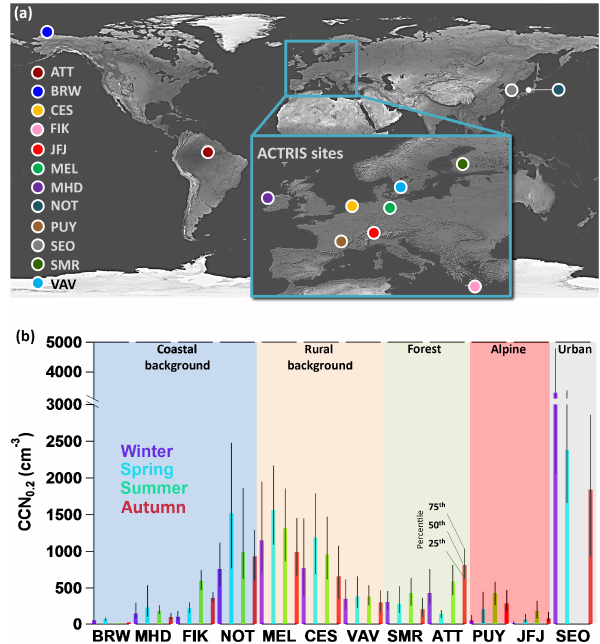
Figure 1. (a) Map showing all measurement sites. Station abbrevi- ations are given in Table 1. All stations in Europe are part of the ACTRIS network. This map is adapted from Natural Earth III and Schmale et al. (2017). (b) Median and interquartile ranges of the seasonal CCN number concentrations at a supersaturation of 0.2% are displayed for each station. The shaded areas group the stations into the classifications